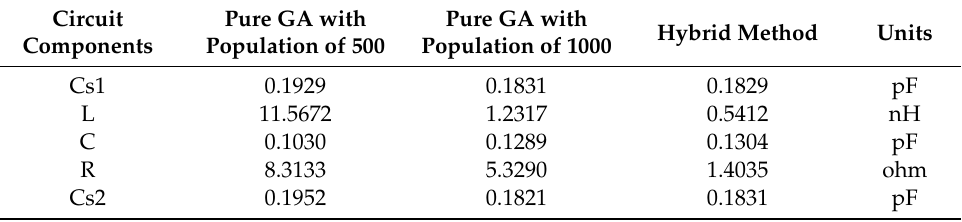
Figure 10. Comparison of S-parameters of the microstrip interdigital capacitor between UltraEM® simulation and equivalent circuit simulation modeled by pure GA with population of 500, pure GA with population of 500 and hybrid GA–Powell’s method. ( a ) Amplitude comparison of S-parameters S11; ( b ) amplitude comparison of S-parameters S21; ( c ) phase comparison of S-parameters S11; ( d ) phase comparison of S-parameters S21. Table 6. Results of microstrip interdigital capacitor parameters extraction.